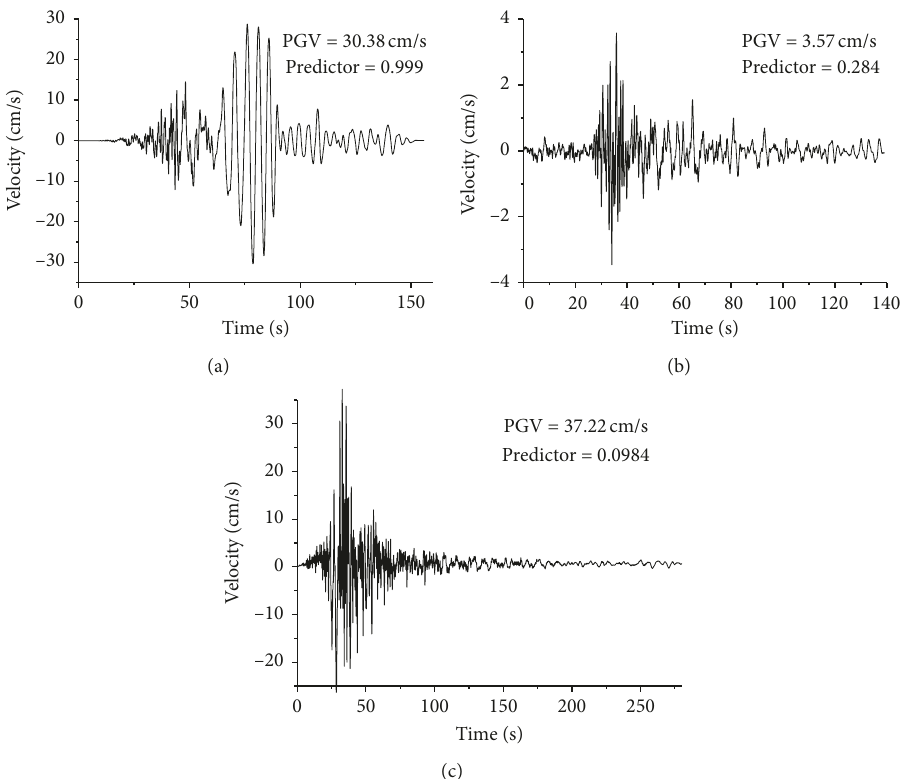
Figure 1: Examples of velocity histories for recordings from (a) 1999 ILA056NS, Chi-Chi, M7.6, earthquake; (b) 2008 TCG006NS, Iwate- Miyagi Nairiku, M7.2, earthquake; (c) 2003 HDKH06NS, Tokachi, M8, earthquake,